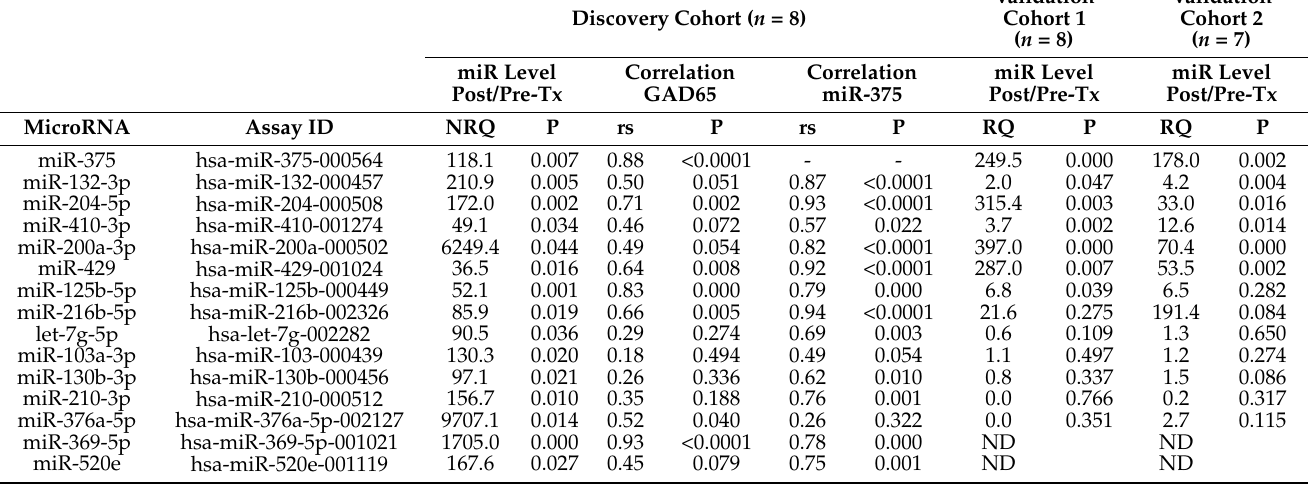
Table 1. Panel of 15 candidate microRNA biomarkers of beta cell destruction identified in the discovery cohort and subjected to independent blinded validation. The table lists, from left to right, the microRNA name and corresponding TaqMan ® hydrolysis probe used for targeted confirmation, the average Normalized Relative Quantity (NRQ) after global mean normalization, and the Spearman Rank correlation coefficient to plasma GAD65 and miR-375 of the 15 candidate biomarker microRNAs selected, as shown in Figure 1 in the discovery cohort ( n = 8). Right columns show the average Relative Quantitity (RQ) after versus before transplantation and the corresponding p -value (paired student t -test) in the independent validation cohort 1 (Brussels, n = 8) and validation cohort 2 (Milan, n = 7). ND: not detected. Tx: islet